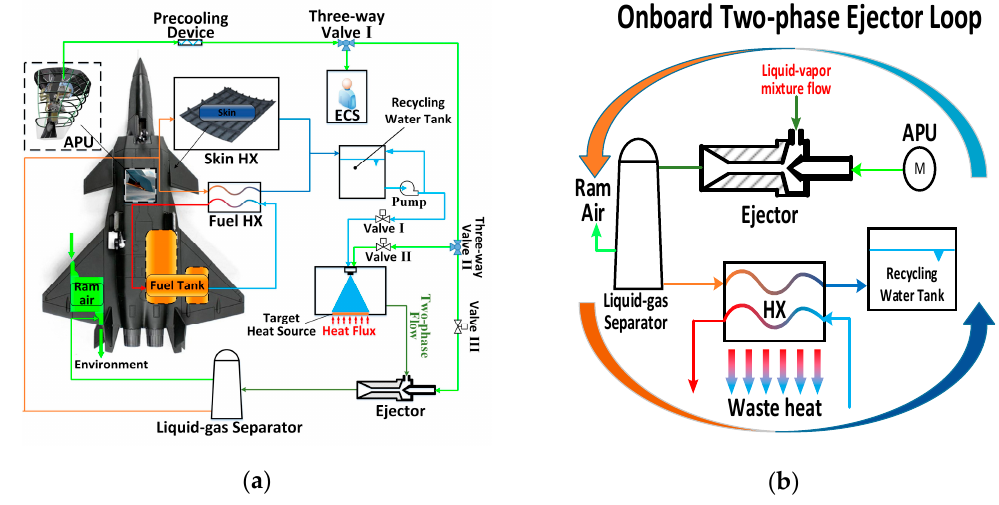
Figure 1. Concept design of the proposed onboard ABSCS, ( a ) Schematic view and ( b ) Description of the onboard two-phase ejector loop.